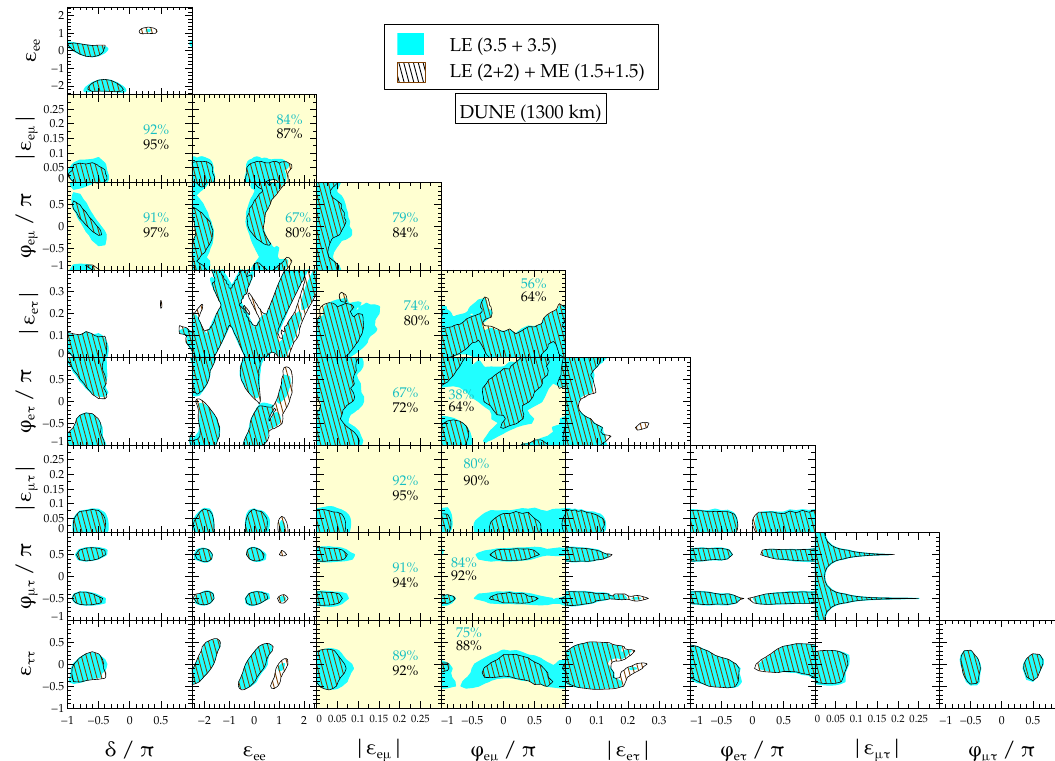
Figure 22.5: A comparison of the sensitivity of DUNE to probe the NSI parameters at 99% confidence level when a standard low energy (LE) beam tune is used (cyan region) and when a combination of low and medium energy (LE + ME) beam tune is used (black hatched region), keeping the total runtime same (3.5 years of ν + 3.5 years of ¯ ν run) for both scenario. In the latter case, the total runtime is distributed between the LE beam (2 years of ν + 2 years of ¯ ν ) and the medium energy beam (1.5 years of ν + 1.5 years of ¯ ν ). The panels with a light yellow (white) background indicate significant improvement (no improvement) by using LE + ME beam over using LE only. The numbers in the light yellow shaded panels correspond to the area lying outside the contour for the two cases (cyan for LE and black for LE + ME) expressed as a percentage of the total parameter space plotted. These numbers quantify the improvement over the LE only option when the ME beam tune is used in conjunction with the LE beam tune in these panels. (taken from [ 389 ]